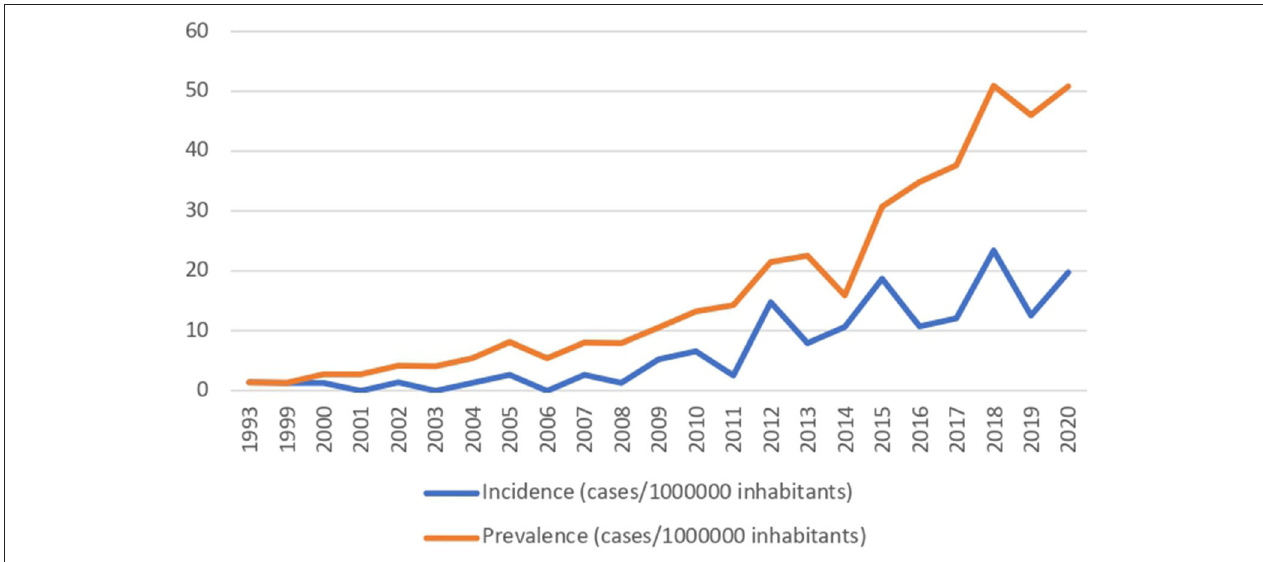
FIGURE 1 | Incidence and prevalence trends of CIF along the study